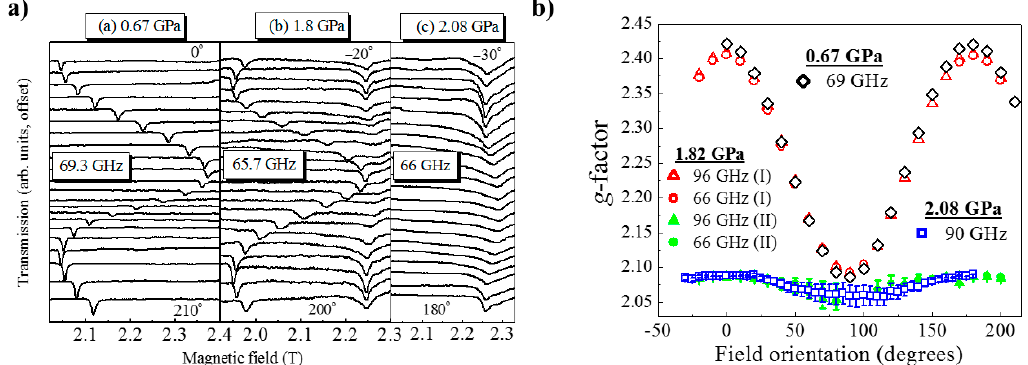
Figure 17. ( a ) Experimental electron paramagnetic resonance (EPR) spectra recorded at 10 K as a function of field orientation within the ab plane of a single crystal (transmission o ff set). The three panels correspond to three di ff erent pressures and microwave frequencies. Spectra were recorded every 10 ◦ , with 0 ◦ corresponding to the field along the a -axis; the field orientations corresponding to the top and bottom traces are indicated in each panel. ( b ) EPR peak positions taken from ( a ) together with data obtained at other frequencies (not shown), which are plotted as their corresponding g -factors versus the orientation of the applied field within the ab plane of the crystal.